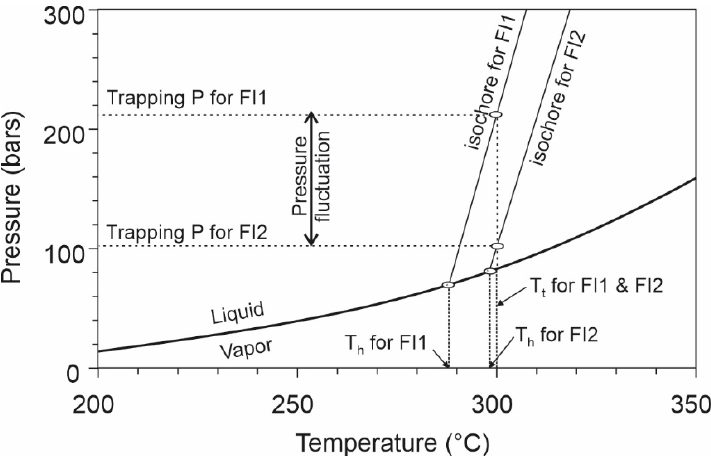
Figure 6. P–T phase diagram for a H 2 O–NaCl system with a salinity of 10 wt% showing the liquid–vapor boundary and isochores of two fluid inclusions entrapped at different P–T conditions, illustrating how fluctuation of fluid pressure between lithostatic and hydrostatic values may result in a variation of T h values of fluid inclusions without changing the trapping temperature. Isochores and liquid–vapor phase boundaries were calculated with the program of Steele-MacInnis et al. (2012) [50]. See text for discussion.